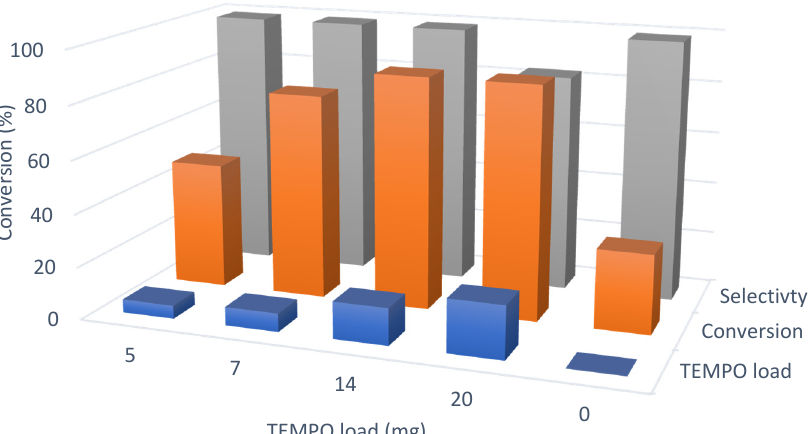
Figure 9. Optimization of the reaction parameters for the oxidation of vanillyl alcohol (VAL) to vanillin (VN) with respect to the TEMPO load. Reaction conditions: 1 mmol vanillyl alcohol, 0.4 mol.% NiFe 2 O 4, air, rt, 10 mL ACN, base 2 equiv., and 6 h reaction time. Conversion was determined by GC using 1,2-dichlorobenzene as the internal standard.